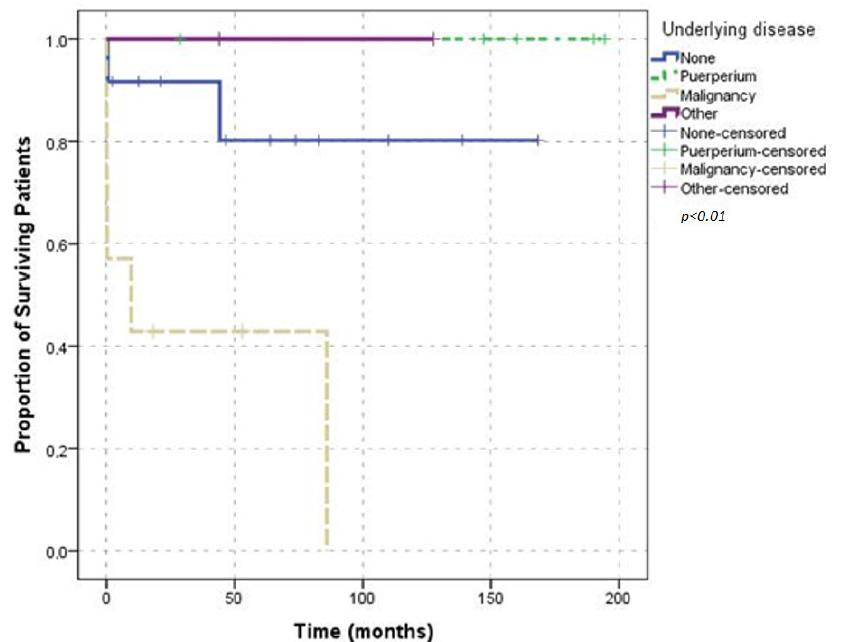
Figure 6. Overall survival according to underlying disease.